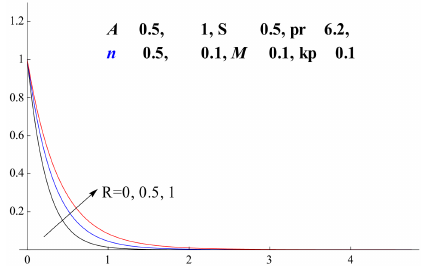
Figure 8. Temperature profile with increasing radiation parameter ( R